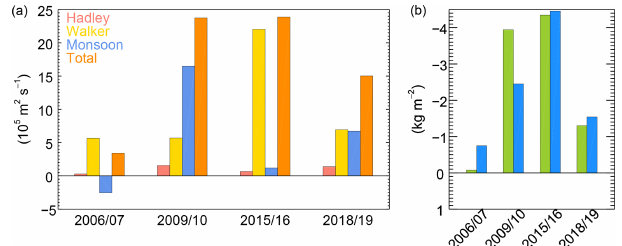
Figure 9. (a) Indices of Hadley (red), Walker (yellow), mon- soon (blue), and total (orange) circulation anomalies and (b) CWV anomalies derived from radiosonde (azure) and reanalysis (green) data at five radiosonde stations in four El Niño